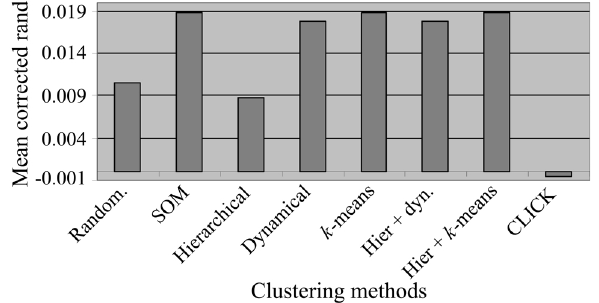
Figure 3 - Mean of corrected Rand values from the FC CDC 25 experi- ments.